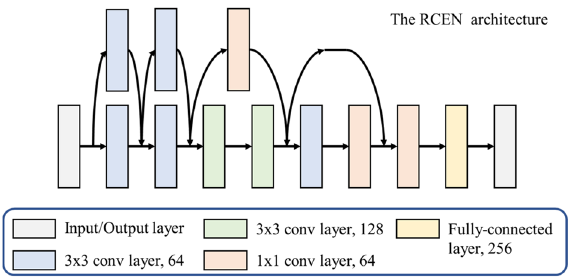
Figure 5. The network architecture for RCEN with 11 parameter